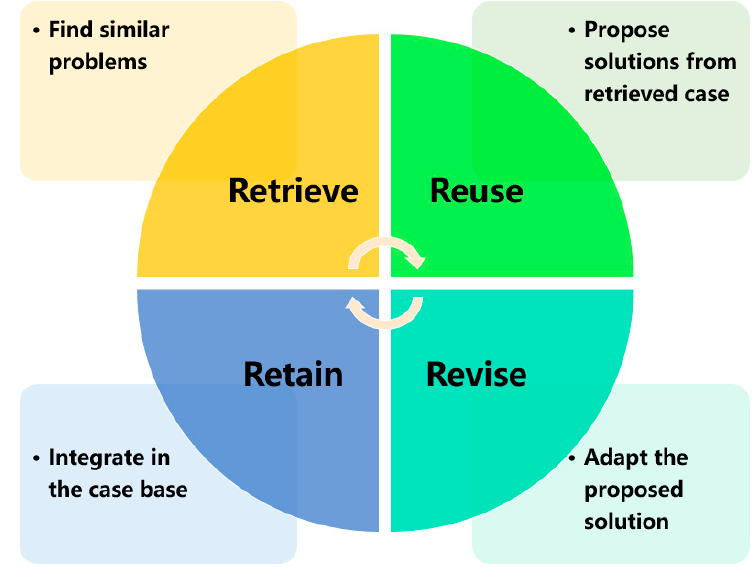
Figure 1. A generic workflow of case ‐ based reasoning.